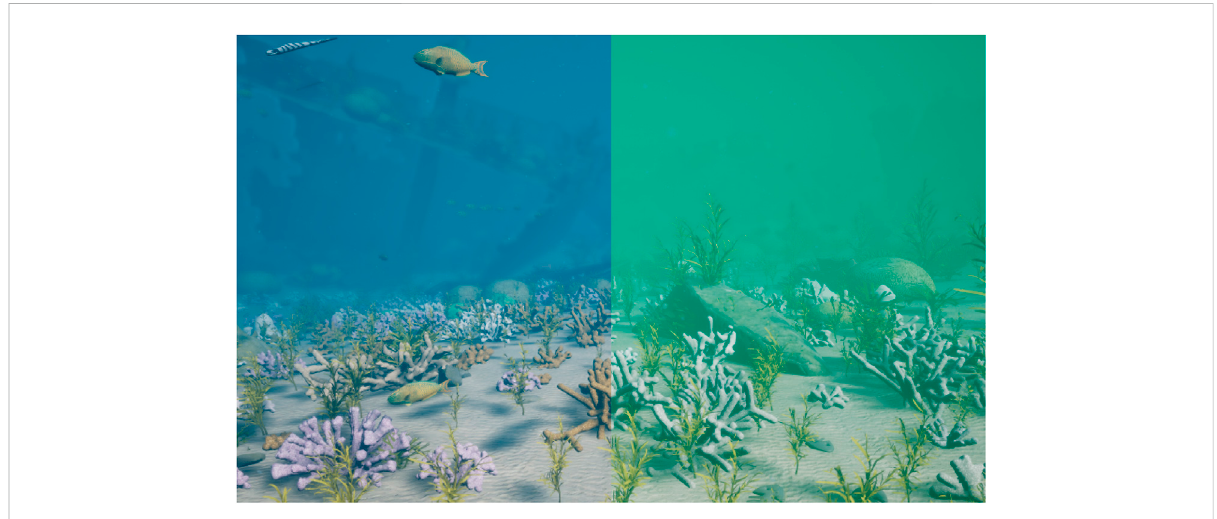
FIGURE 3 Comparison of a healthy reef (left) with an unhealthy reef (right). Notice the greenish color of the water, the absence of animals, and the bleached